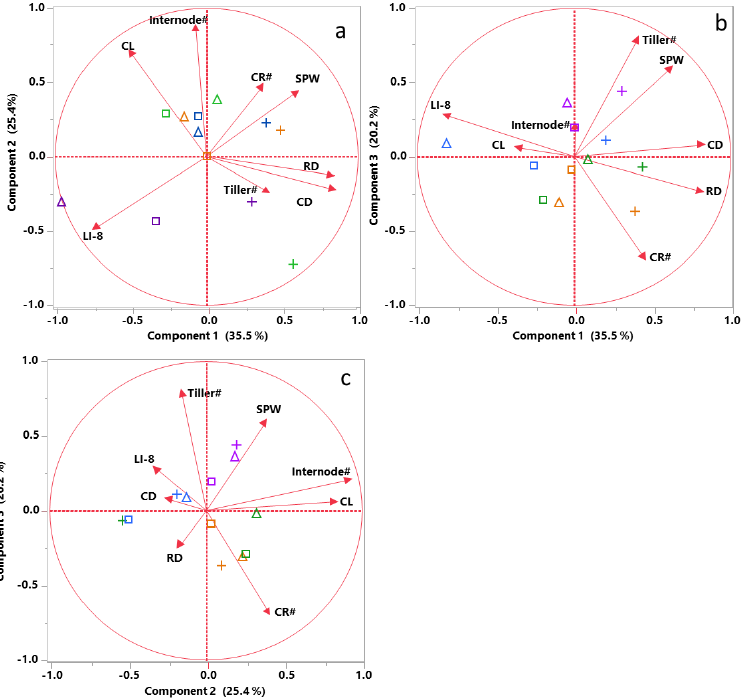
Figure 8. Principal component analysis of lodging index at 8 weeks after emergence (LI-8) and lodging-related morphological traits assessed during that week. The three principal components are presented in all combinations: 1 and 2 ( a ), 1 and 3 ( b ), and 2 and 3 ( c ). Opposing vectors indicate a negative association between traits, whereas vectors with similar directions indicate a positive association. Squares, triangles, and pluses represent 9 kg / ha, 6 kg / ha, and 3 kg / ha sowing rates, respectively. Purple, blue, orange, and green shapes represent accessions RTC-400, RTC-2, RTC-361, and RTC-119, respectively. Crown diameter (CD), root diameter (RD), number of crown roots (CR#), and single-plant weight (SPW).